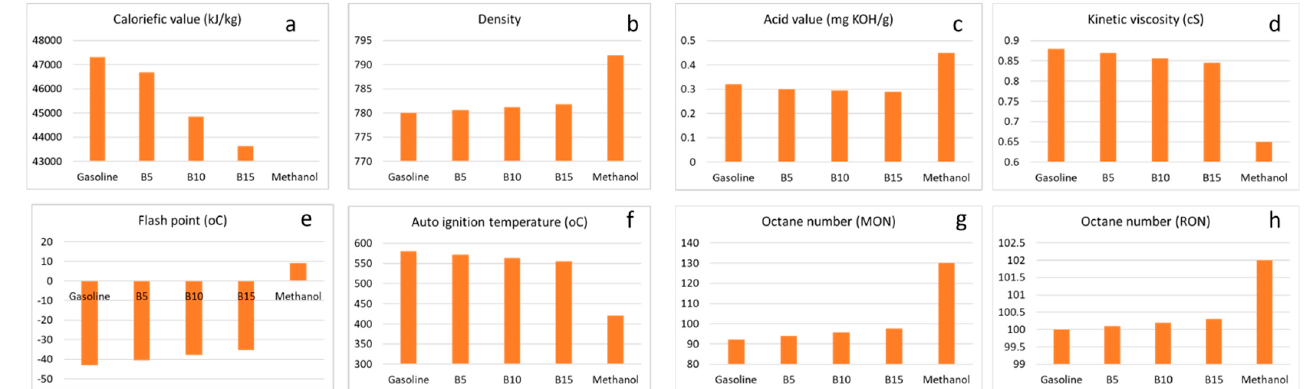
Figure 3. Fuel carbon redundancy effect on fuel characteristics: ( a )calorific value(kJ/kg); ( b )blend density (kg/m 3 ); ( c ) acid value (mg KOH/g); ( d ) fuel kinetic viscosity(cS); ( e ) flash point ( ◦